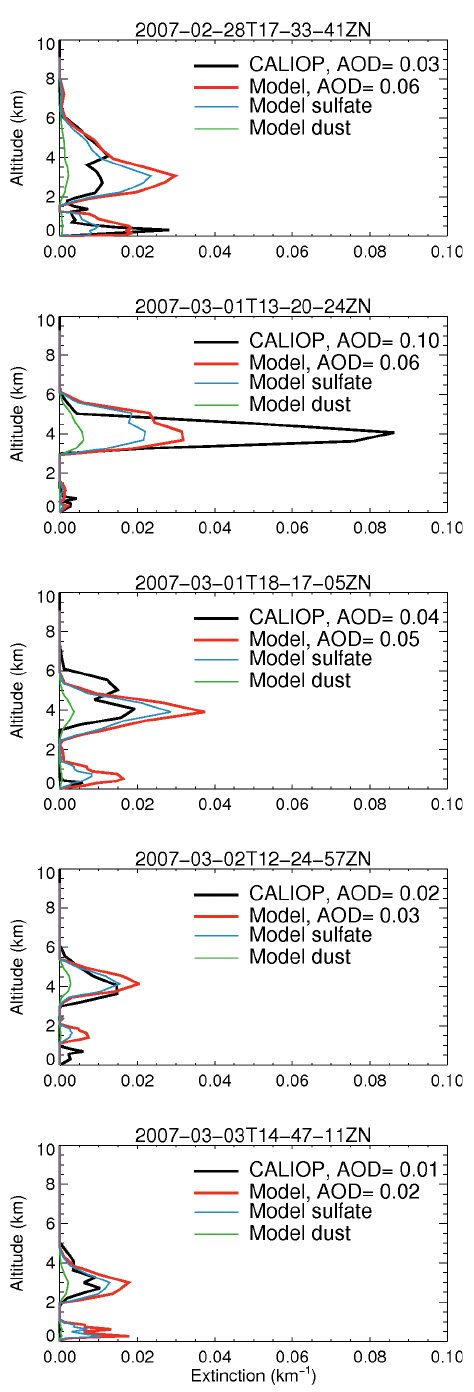
Fig. 5. CALIOP (black) and GEOS-Chem (red) mean aerosol ex- Figure 5. CALIOP (black) and GEOS-Chem (red) mean aerosol extinction profiles for the cloud-free regions within the tinction profiles for the cloud-free regions within the red boxes in red boxes in Figure 4. The CALIOP sensitivity threshold is applied to the modeled extinction profiles. The CALIOP Fig. 4. The CALIOP sensitivity threshold is applied to the mod- eled extinction profiles. The CALIOP extinction is gridded onto the extinction is gridded onto the GEOS-Chem vertical grid. The green and blue lines represent the extinction attributed to GEOS-Chem vertical grid. The green and blue lines represent the dust and sulfate respectively. The modeled and observed AOD, calculated by integration of the extinction profile over the extinction attributed to dust and sulfate respectively. The modeled vertical extent of each plume are listed on each panel. and observed AOD, calculated by integration of the extinction pro- file over the vertical extent of each plume are listed on each panel.